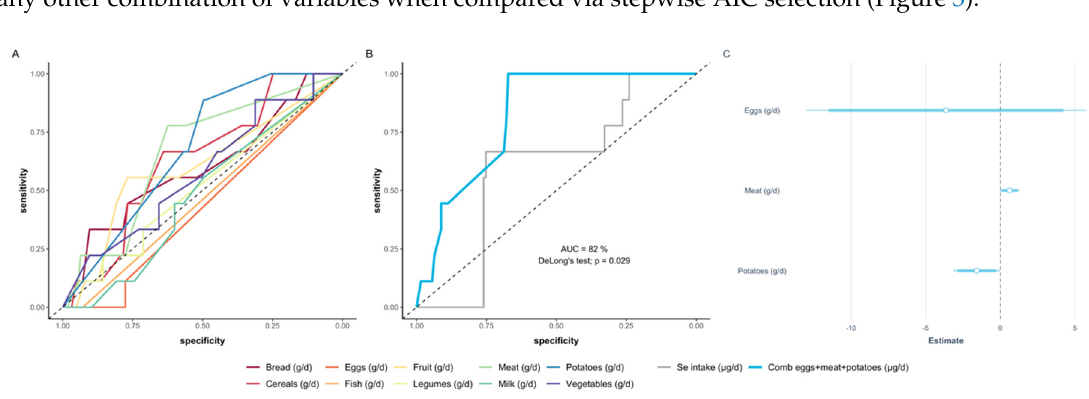
Figure 3. ROC-analysis of di ff erent food categories to di ff erentiate between Se-deficient and Se-replete subjects. ( A ) Absolute intakes of several food categories (g / day) yielded similar results and poor predictive information. ( B ) The multiple regression model based on eggs, meat and potatoes intakes outperformed any other combination of variables via stepwise AIC selection. The final model (blue) based on these three parameters yielded a high AUC of 82%, and performed significantly better compared to the model based on the calculated Se intake (grey) from all categories deduced via the available composition data (DeLong’s test, p = 0.029). ( C ) The estimates of the final model are given alongside with the corresponding confidence